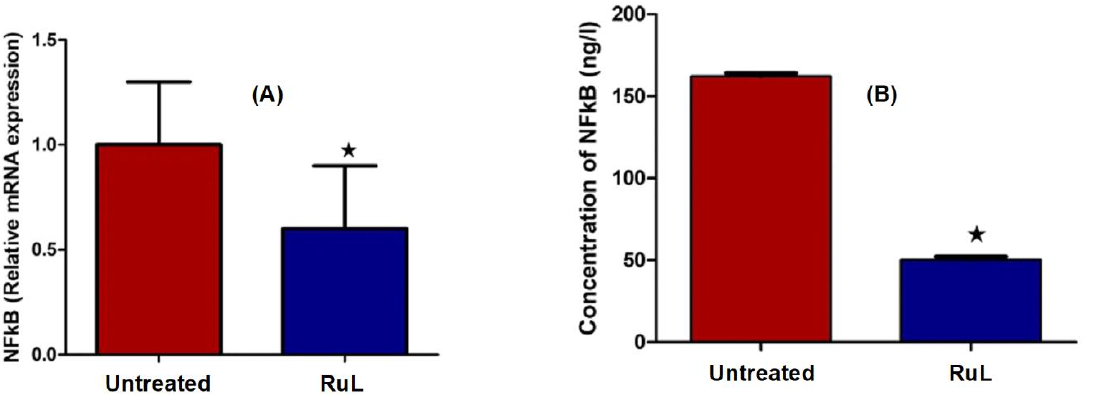
Figure 11. Effect of the RuL complex on NF-kB in HepG2 cells: ( A ) gene expression; ( B ) protein levels. Data are expressed as mean ± SD of two independent experiments performed in triplicate. Statistical differences were analyzed with a t -test. * Significant at p < 0.05.